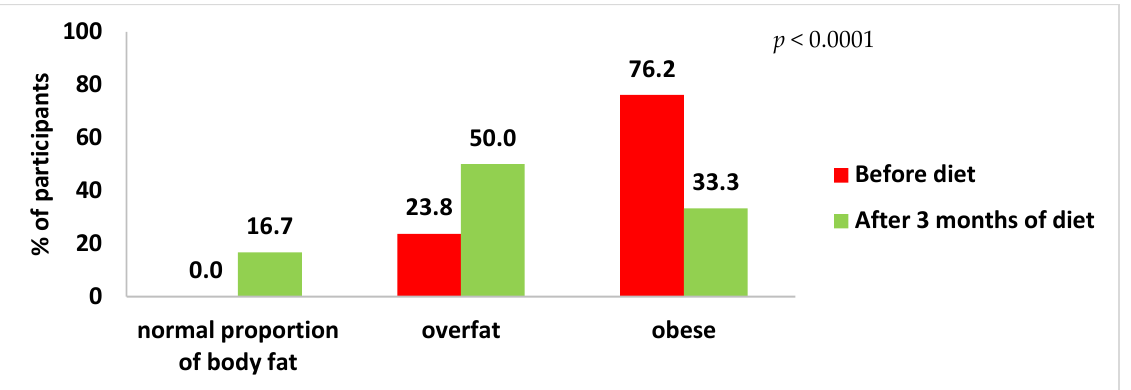
Figure 2. Classification of total female subjects according to body fat content.